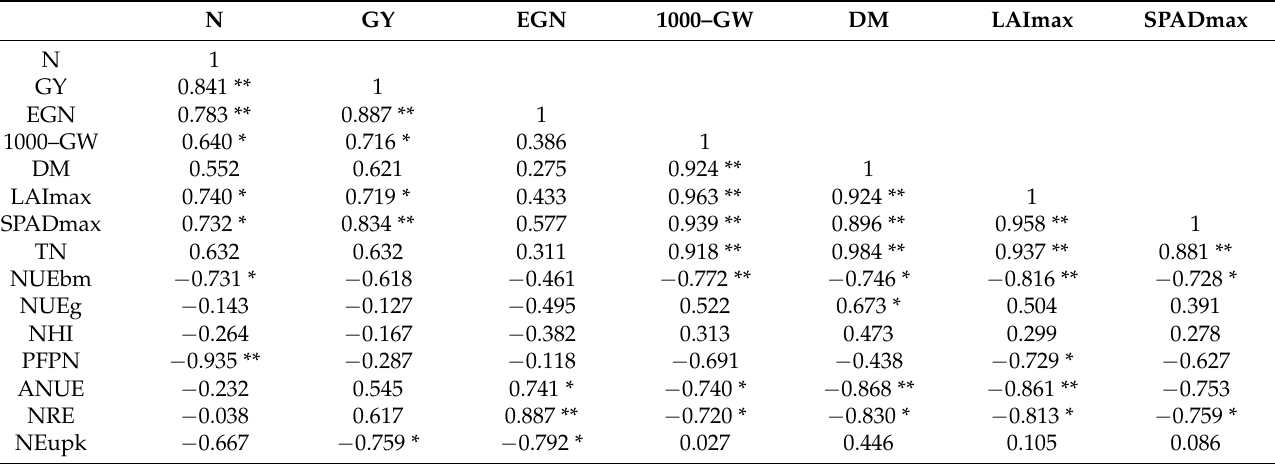
Table 5. The correlations between GY and its components, DM, LAImax and SPADmax, and nitrogen accumulation and utilization of summer